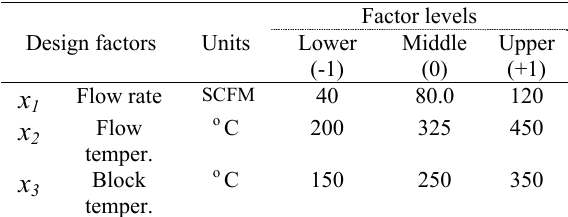
Table 4. Factors and their levels